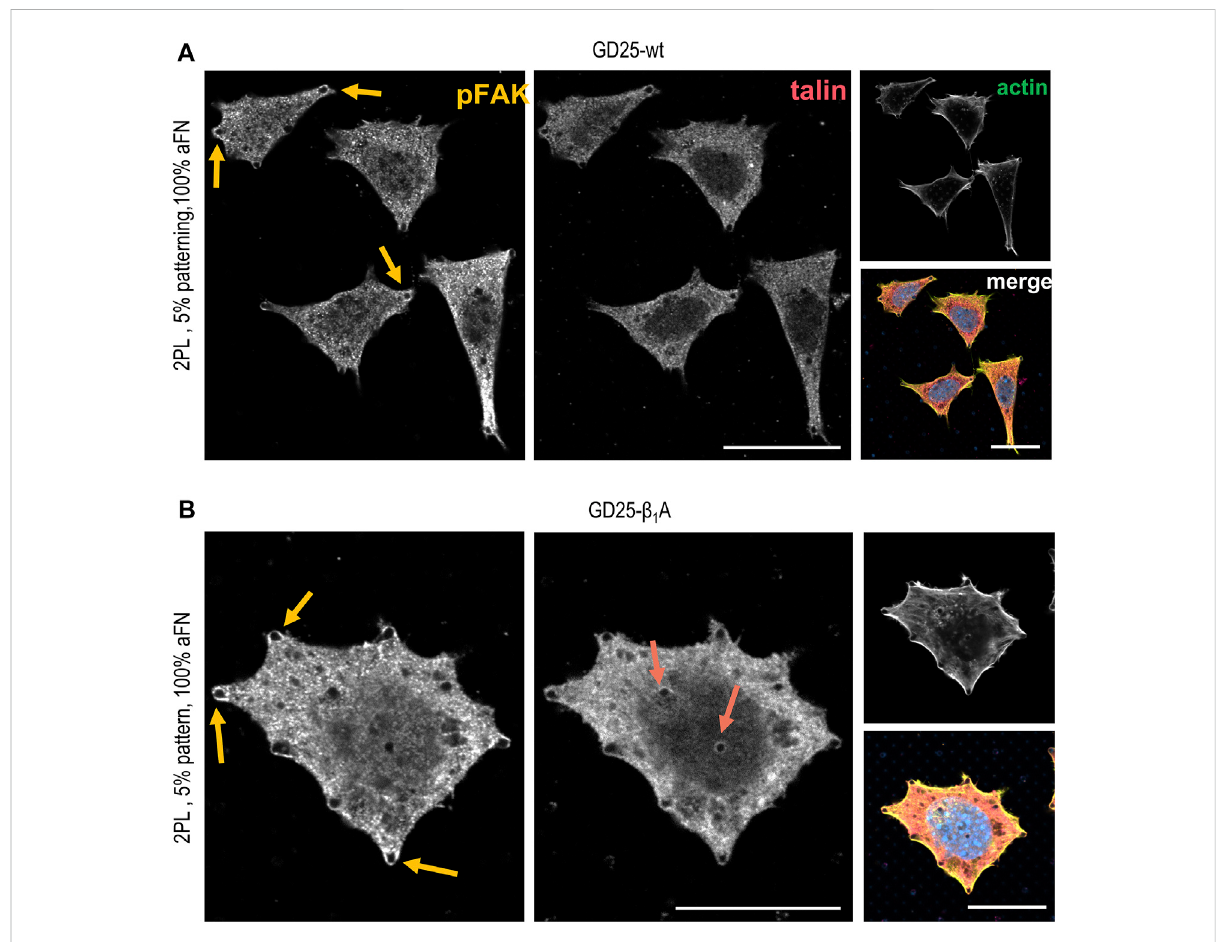
FIGURE 5 Phosphorylated FAK and talin stainings in GD25-wt and GD25- β 1A. (A) GD25-wt cells on 2PL patterned substrates show only peripheral pFAK, while talin is not detectable. (B) Expression of talin in the central contacts of cells with the micro-pillars patterns is restored in the GD25- β 1A line, which also shows peripheral pFAK. Scalebar 20